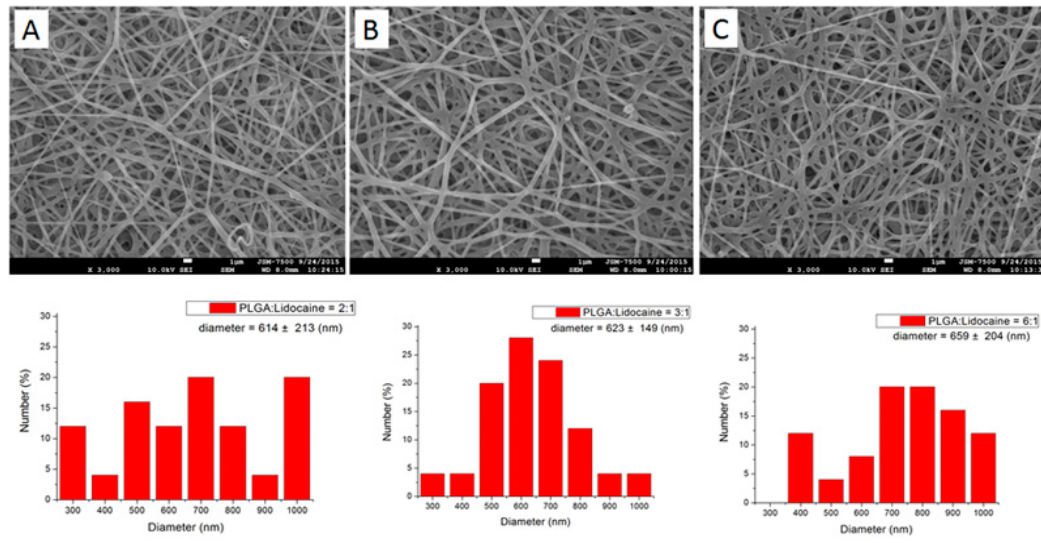
Figure 2. Scanning electron microscopy (SEM) photos and fiber diameter distribution of electrospun